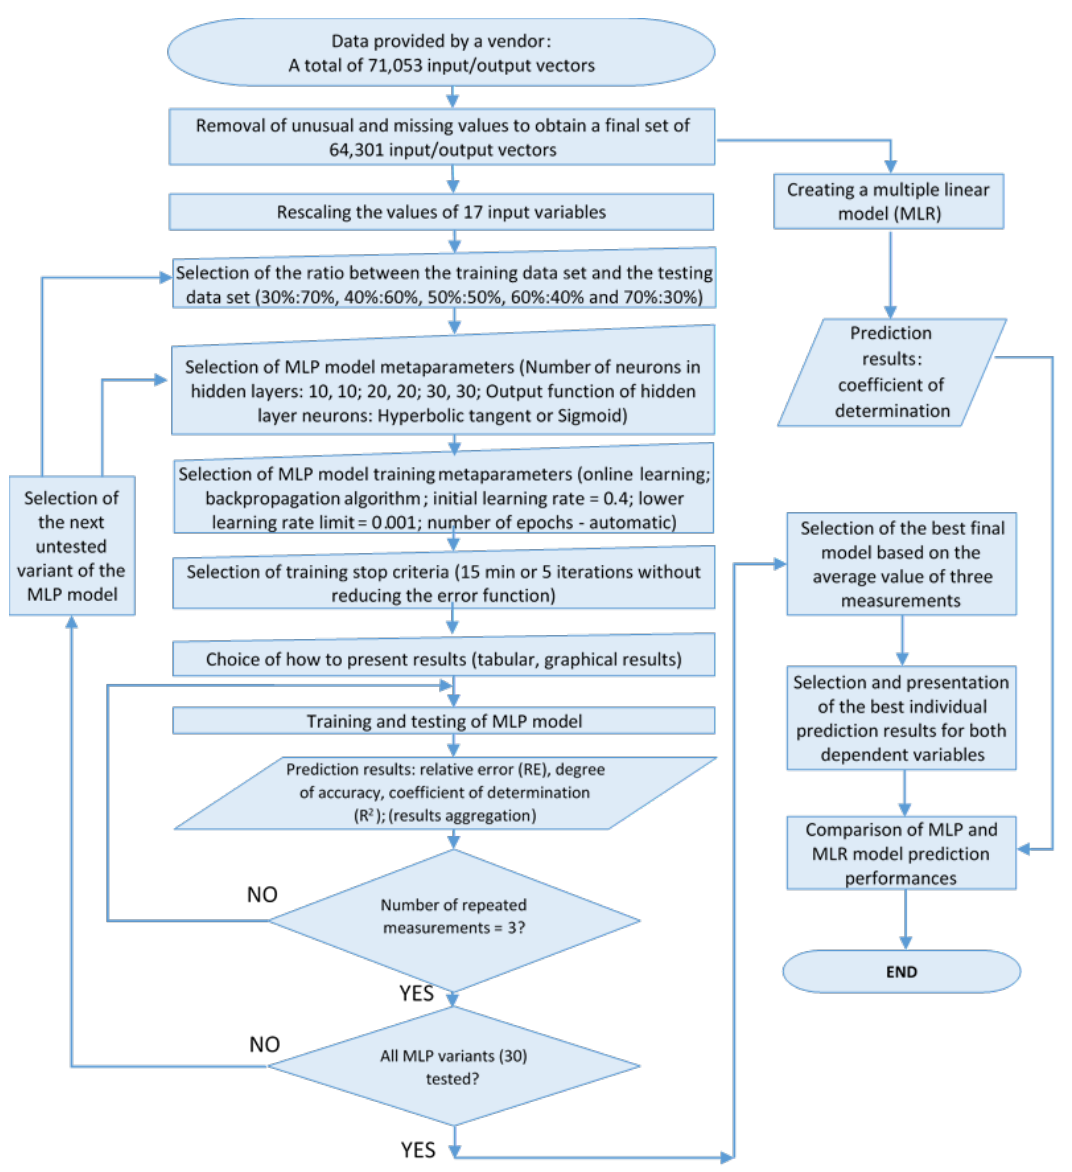
Figure 1. Algorithm for creating MLP model.